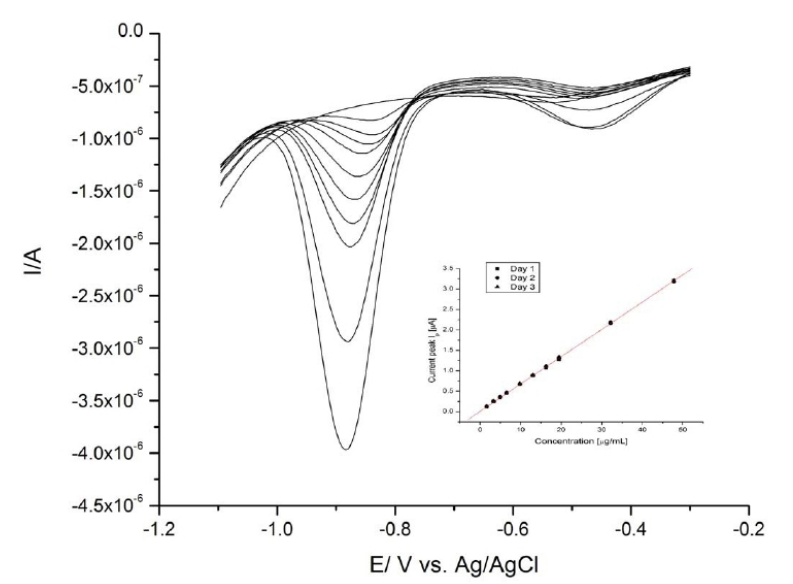
Fig. 3 Differential pulse voltammograms of different concentrations of colchicine in H PO /HClO 0.01 M. Electrode, glassy carbon; scan rate, 10.2 mV s − 1 ; pulse amplitude, 3 4 4